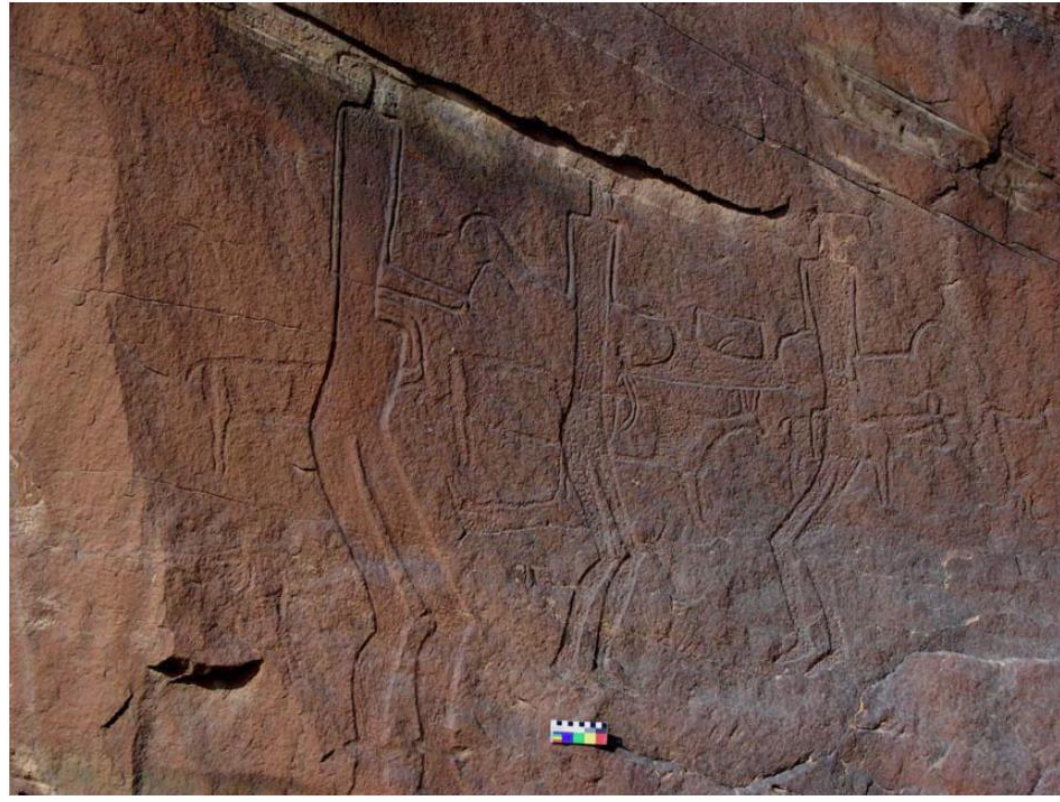
Figure 6. Neolithic society depended on hunting and food gathering. In this image an animal seems to be carried by the people. Jubbah, northern